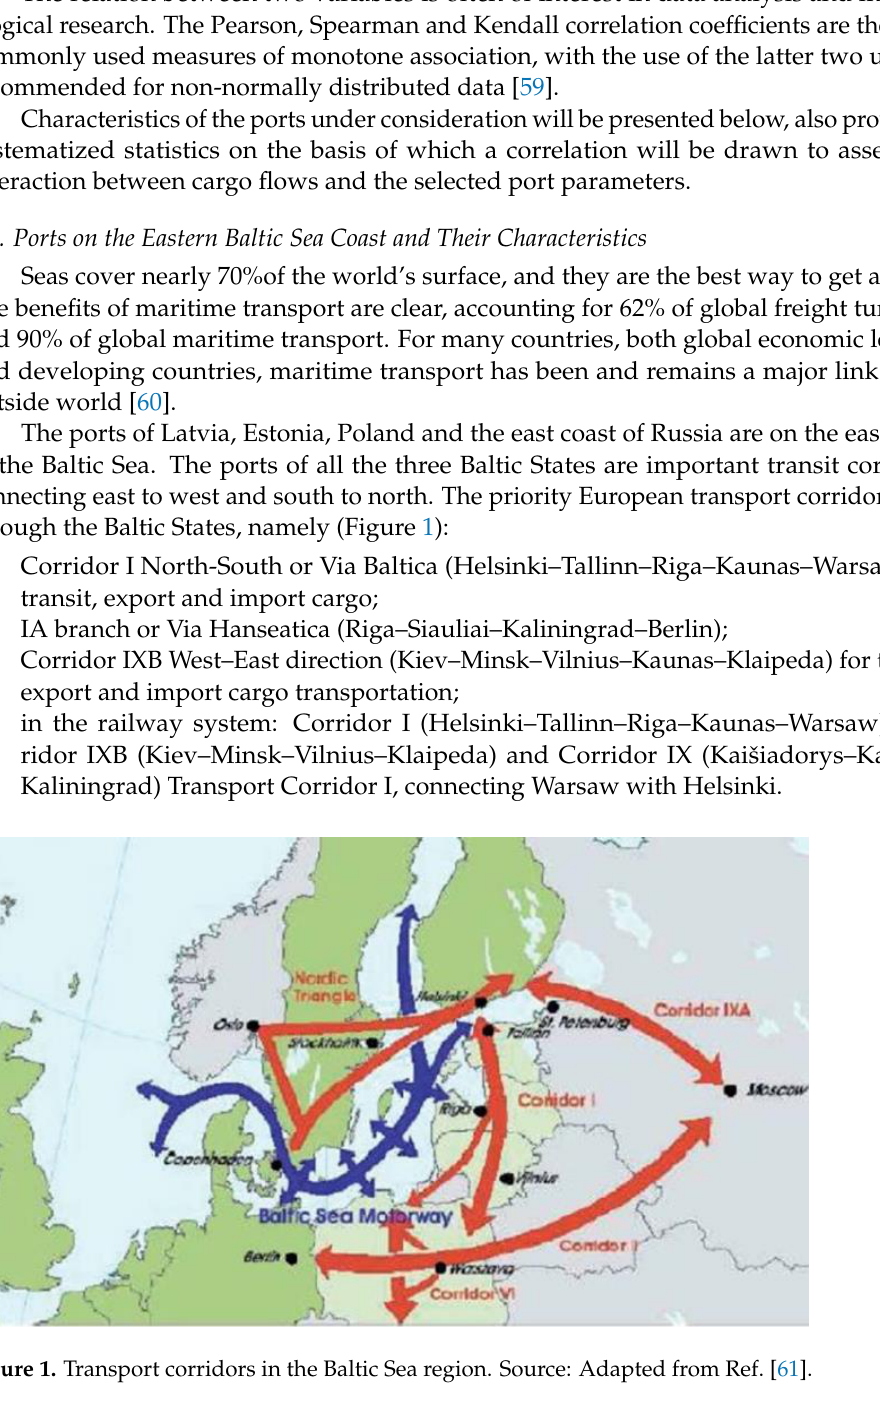
Figure 2. Key ports of the eastern Baltic Sea coast. Source: [62]. This Article analyses 10 ports on the Eastern Baltic Sea coast, which will be analysed by country: 1. Lithuania. Having a non-freezing port and being in the central part of Europe geo- graphically, Lithuania can be called a transport bridge between the West and the East. The Klaipeda Seaport (Figure 3) is the closest to ports of West and North Europe and to South Scandinavian ports.